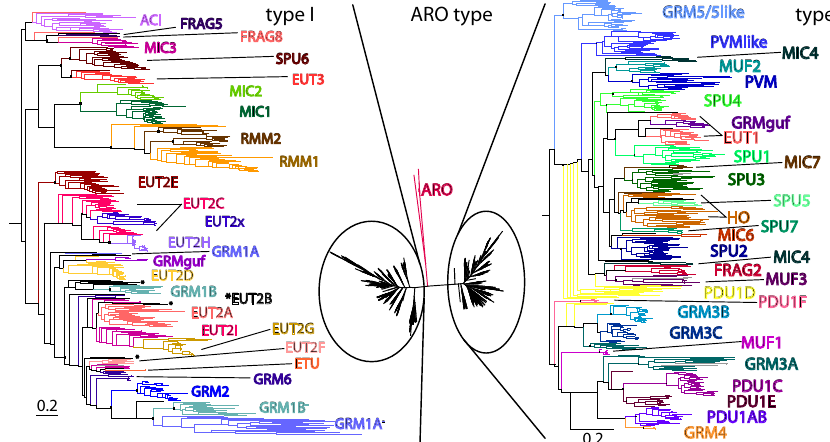
Fig. 5 Phylogenetic tree of pfam00171 aldehyde dehydrogenases from BMC loci. Sequence redundancy was reduced by limiting to 30 sequences per BMC type (based on percent identity). Three major groups were identi fi ed: type I, which is dominated by EUT2, belongs to IPR013357, and contains a C- terminal EP (left); the ARO type outlier clade; and type II, which belongs to IPR012408, contains an N-terminal EP, and contains a larger diversity of BMC types, relative to type I AldDhs. Branch lengths are scaled by the number of substitutions per site. Bootstrap values for important nodes are represented as black squares (above 50%). GRM1A and GRM1B loci contain a putatively inactive second copy (marked with a “ - “ superscript). EUT2B AldDh marked with an asterisk are found in different basal